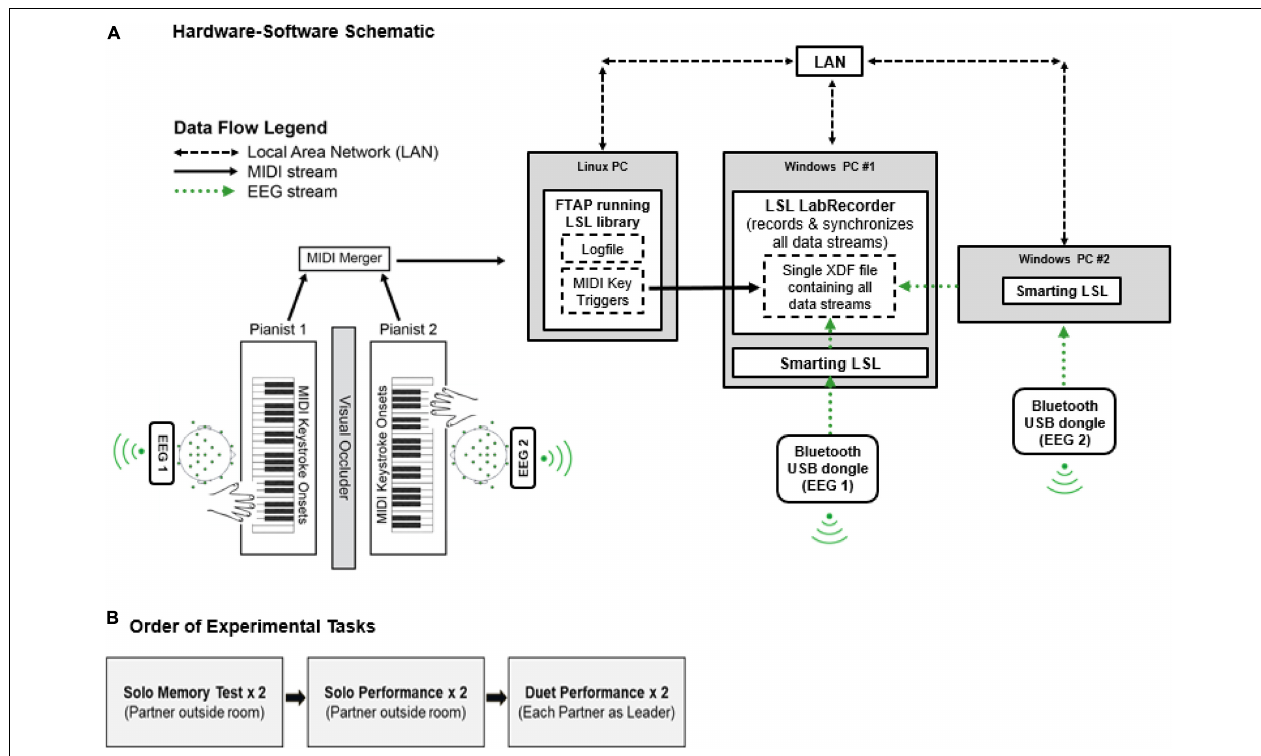
FIGURE 1 | (A) Hardware-software schematic. MIDI keystroke data (solid black arrows) from duet pianists are merged and sent to FTAP software running the LSL library in a Linux OS. LSL sends MIDI time-stamps over the Local Area Network (LAN, dashed black arrows) to LabRecorder software, where timestamps are recorded as keystroke event triggers. EEG data streams (dotted green arrows) from duet pianists are sent via Bluetooth to SmartingLSL software running the LSL Library in a Windows OS. LSL sends EEG data streams to LabRecorder software. LabRecorder software synchronizes MIDI and EEG data streams by correcting for clock offsets between respective data acquisition computers (Linux/Windows). Synchronized data streams are stored in a single XDF file for storage. (B) Order of Experimental